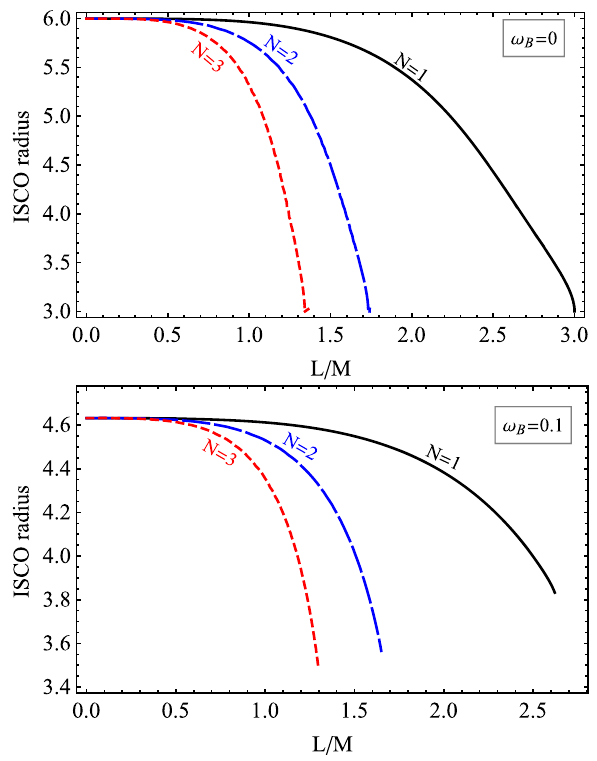
Fig. 9 Dependence of the ISCO radius of neutral and charged particles from the conformal parameter L for various values of the parameter